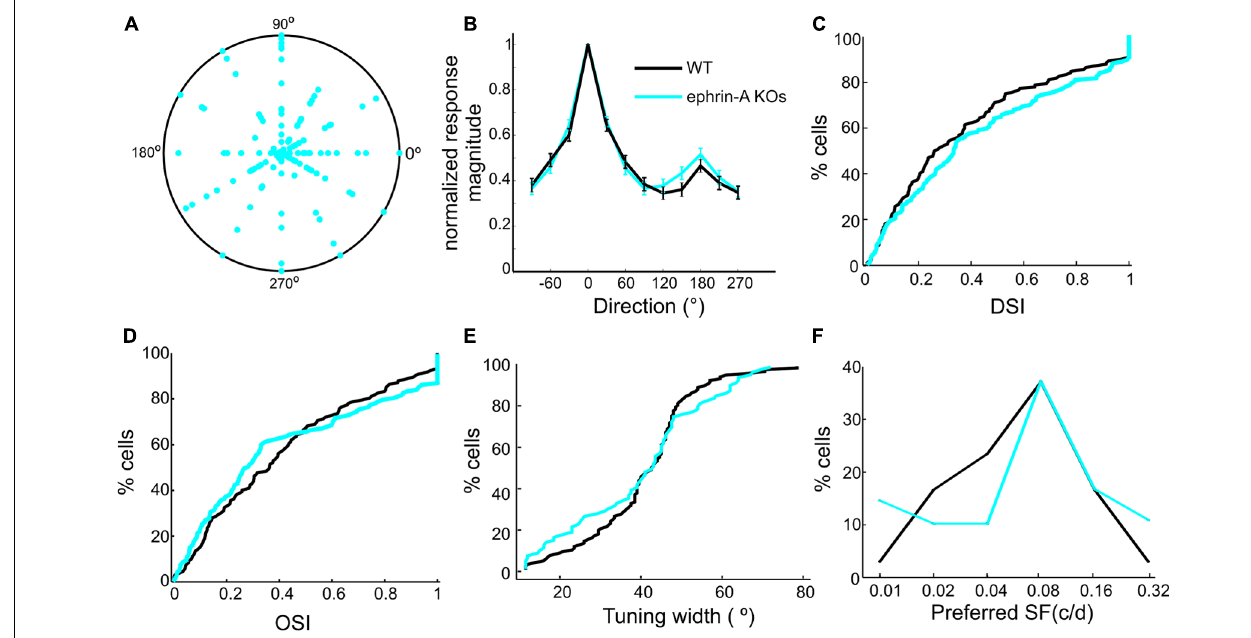
FIGURE 4 | Normal responses to drifting gratings in ephrin-A KOs. (A) Polar plot of direction selectivity index (DSI, radii from origin) and preferred directions (angles). Each dot is from one cell. The outer circle represents DSI value of 1. (B) Normalized direction tuning curve of ephrin-A KOs and WT SC neurons, plotting the mean and SEM of normalized responses at each direction. (C) Cumulative distribution of DSI in the two genotypes (ephrin-A KOs, mean = 0.43 ± 0.03, median = 0.33, n = 137;